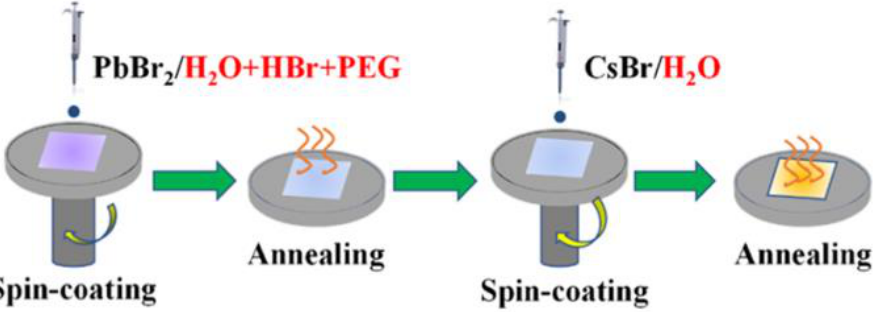
Figure 13. Schematic diagram of the fabrication process of CsPbBr 3 films from aqueous solutions